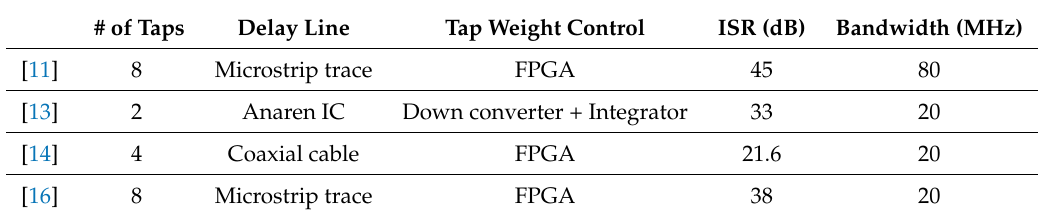
Table 1. Comparison of existing multi-tap adaptive filters.